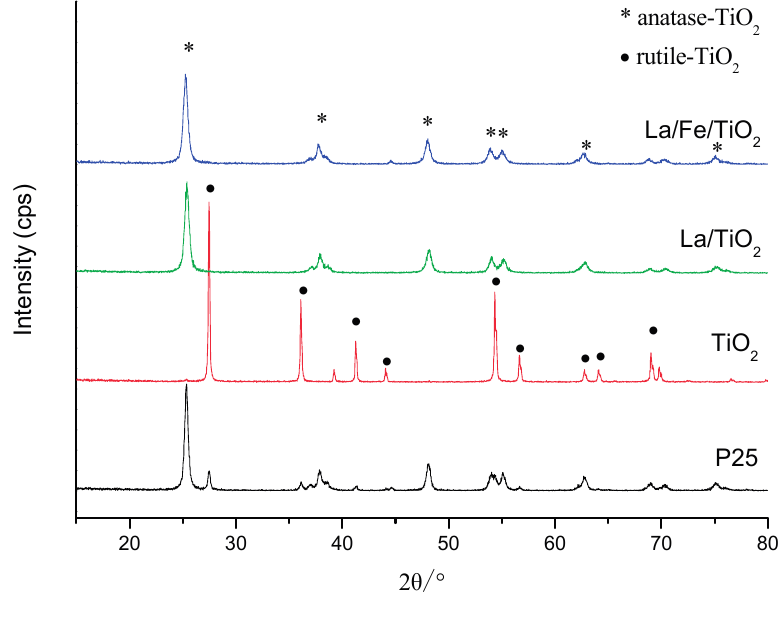
Figure 1. XRD patterns of P25, TiO 2 , La/TiO 2 and La/Fe/TiO 2 .